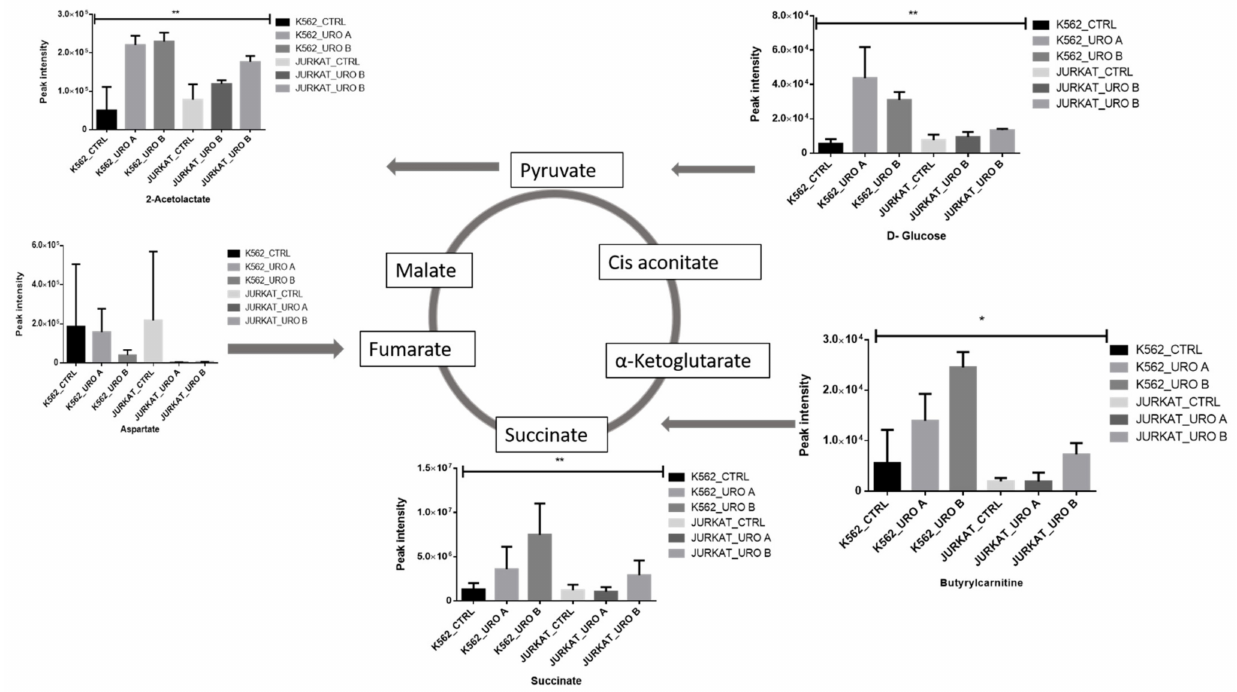
Figure 3. Urolithin A and B both alter crucial cellular energy pathways in leukemic cells. Quantitative levels of various metabolites involved in various energy pathways of control and urolithin A- and urolithin B-treated cells, * p < 0.01. ** p < 0.001.